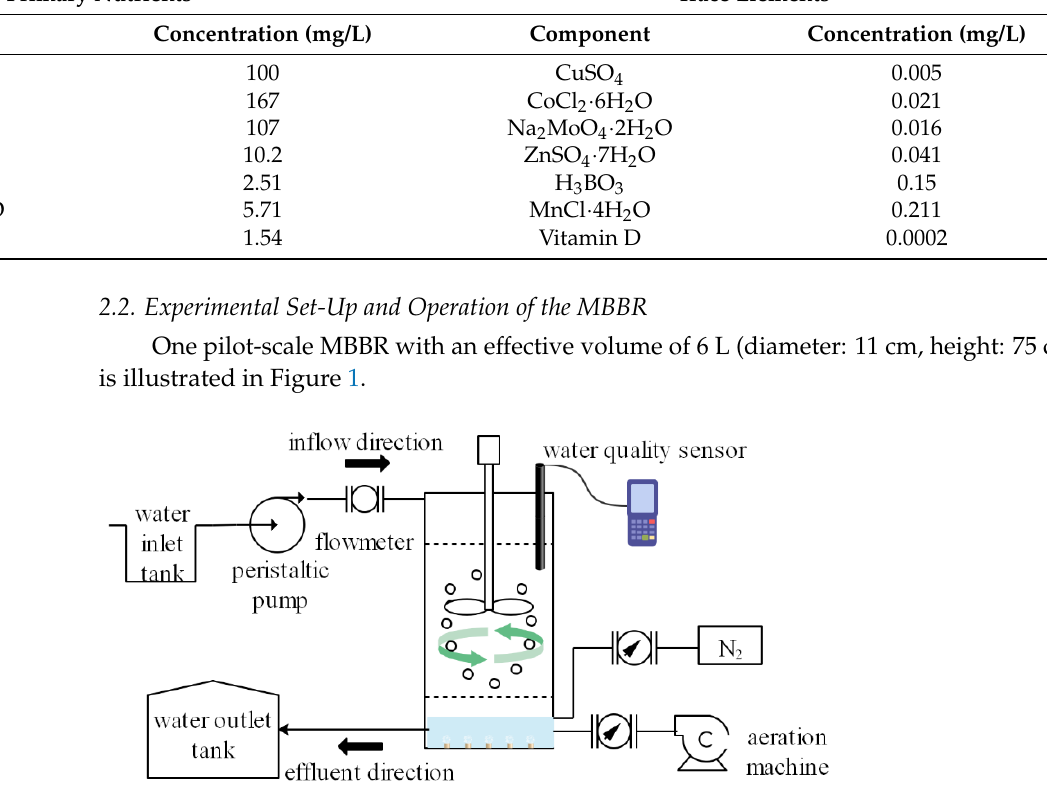
Figure 1. Schematic diagram of the experimental facility.